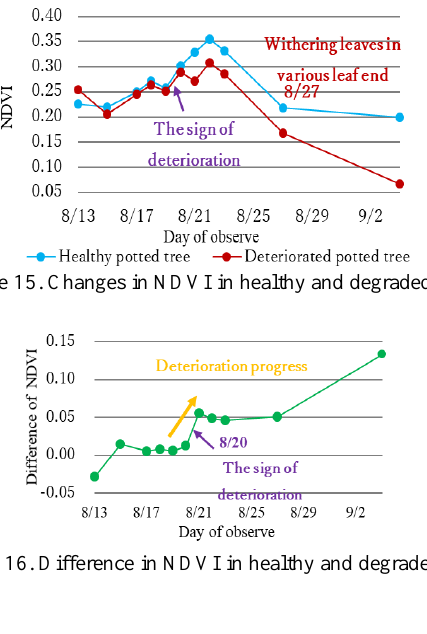
Figure 14. Scatter plots of NDVI and white plate observations 4.2 Observation of NDVI in a tree that was forced to die Two potted conifer trees were prepared and one was injured and forcibly killed by applying an herbicide. A modified near- infrared camera was used to observe the change in NDVI. The NDVI observations are shown in Figure 15.